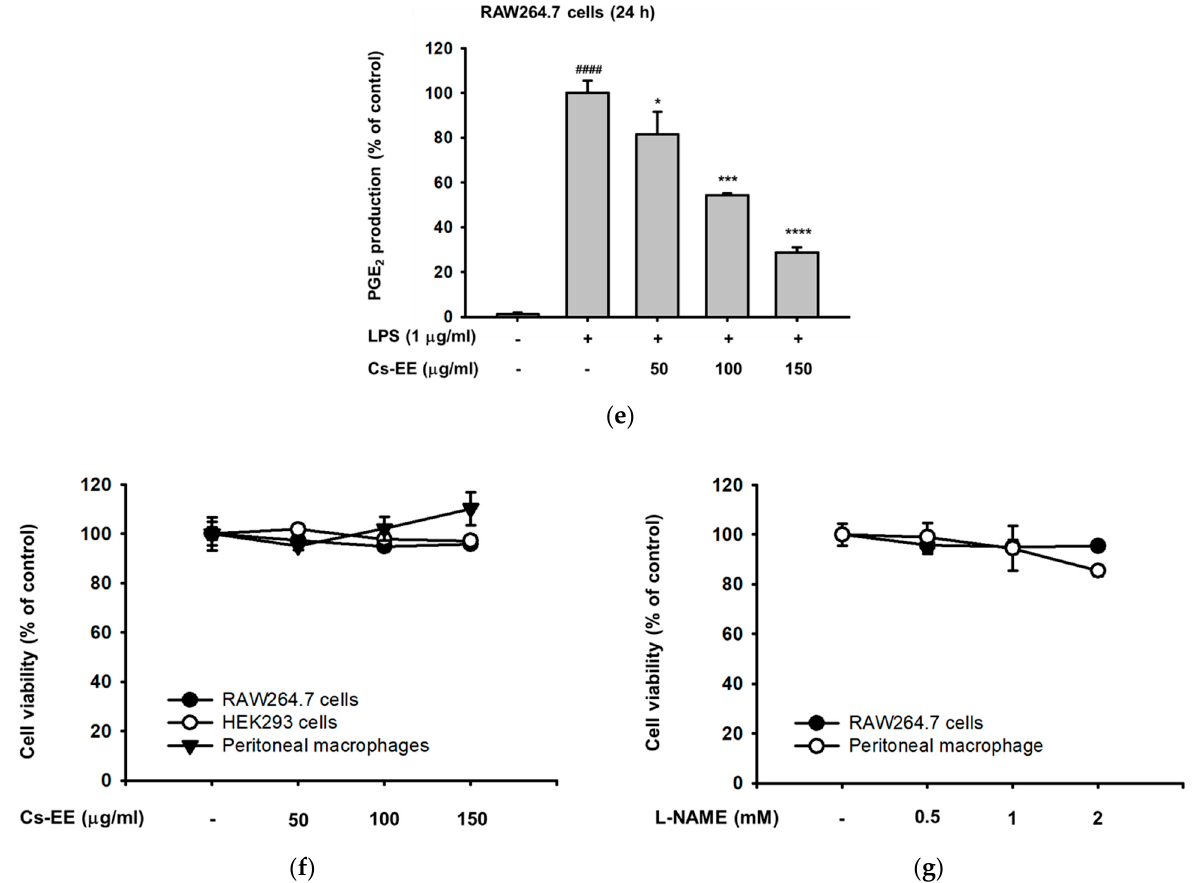
Figure 1. Effect of Cs-EE on the production of inflammatory mediators, and cell viability profile. ( a – d ) Supernatant NO levels in RAW264.7 cell cultures and peritoneal macrophages pre-treated with indicated concentrations of Cs-EE (a,b) or L-NAME (c,d) in the presence or absence of LPS (1 μ g/mL), poly (I:C) (200 μ g/mL), or pam3csk4 (10 μ g/mL) were determined using the Griess assay. ( e ) Supernatant PGE 2 levels in LPS-treated RAW264.7 cells were evaluated by EIA. ( f and g ) Cell viability of RAW264.7 cells, HEK293 cells, and peritoneal macrophages treated with Cs-EE (f) or L-NAME (g) for 24 h were analyzed using the MTT assay. Results (a–g) are expressed as mean ± SD. #### p < 0.0001 compared to normal group (no treatment) by the student’s t -test, and * p < 0.05, ** p < 0.01, *** p < 0.01 and **** p < 0.001 compared to control group (inducer alone) by one-way ANOVA.